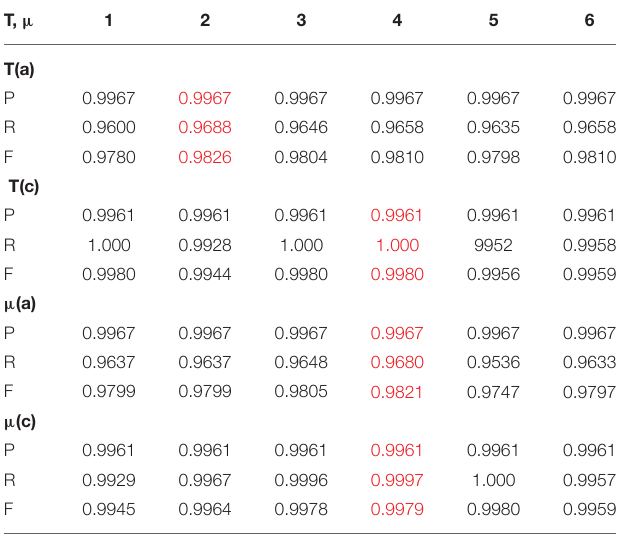
suitable for multiple gliomas T12. Values 6.7 and − 6.7 are good for Anaplastic oligodendroglioma I (AOI). And, the values 6 and − 6 are good values for Anaplastic oligodendroglioma II (AOII), as shown in Table 4